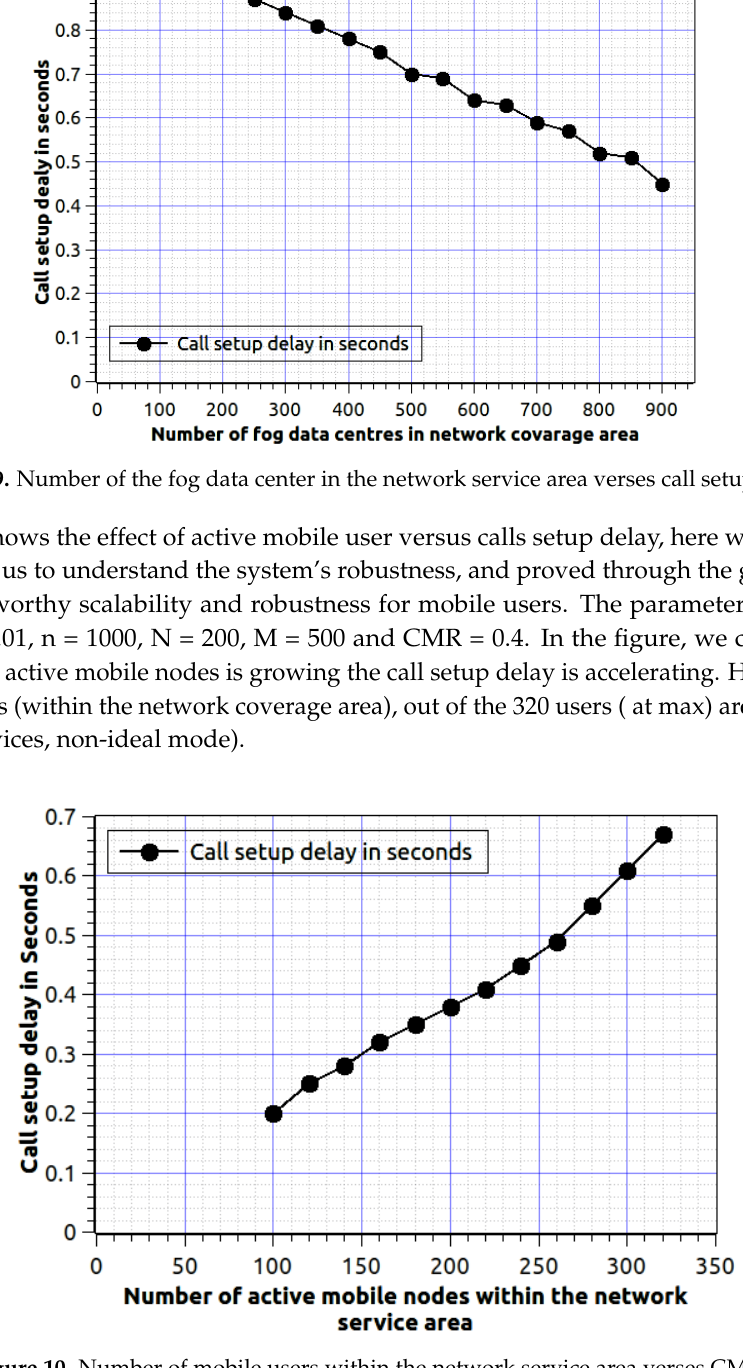
Figure 10. Number of mobile users within the network service area verses